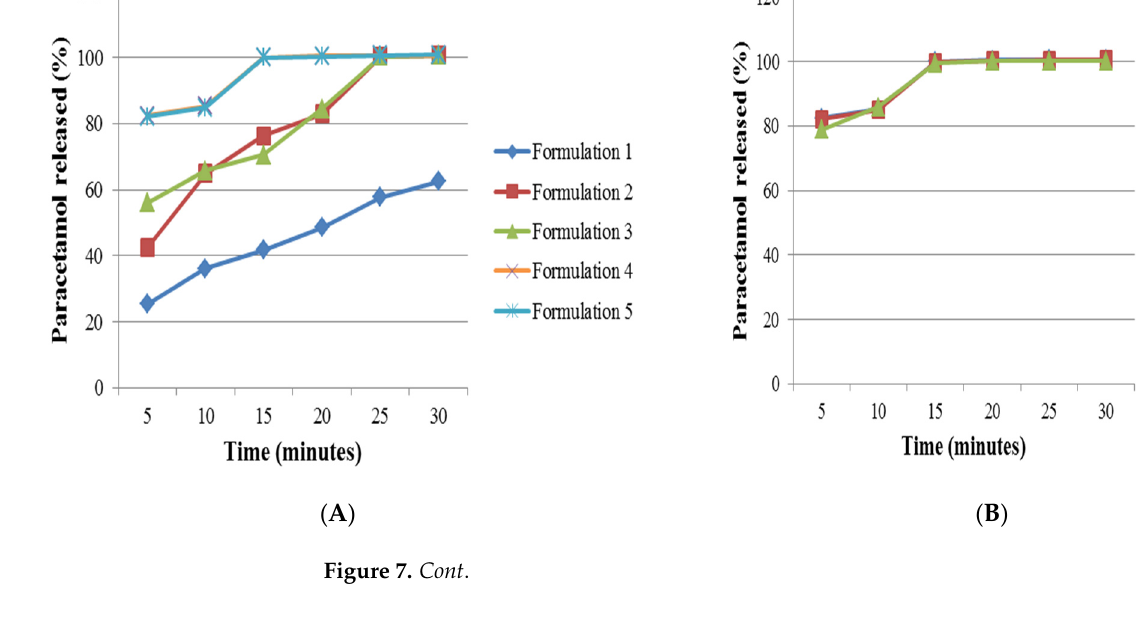
Figure 7. ( A ) Plot of percentage of paracetamol released over time for the dissolution test of each formulation; ( B ) Comparison of paracetamol released (%) between the reference, 3 months and 6 months of storage at conditions 40 ± 2 ° C/75 ± 5% RH for Formulation 4; ( C ) Comparison of para- cetamol released (%) between the reference, 3 months and 6 months of storage at conditions 40 ± 2 ° C/75 ± 5% RH for Formulation 5. Note: n = 6 for all formulations. 4. Conclusions This study indicates that pregelatinised sago starch has the potential to be a new alternative for a directly compressible excipient. Its flow properties were excellent and performed well in the tablet formulations using paracetamol as a model of active ingre- dient, with the resulting tablets exhibiting good stability, satisfactory disintegration time and dissolution properties. Author Contributions: Conceptualization, R.T.W.; methodology, R.T.W.; software, R.T.W.; valida- tion, R.T.W.; formal analysis, R.T.W.; investigation, R.T.W.; resources, R.T.W.; data curation, R.T.W.; writing—original draft preparation, R.T.W.; writing—review and editing, R.T.W., A.H., K.B.L., L.C.M.; visualization, R.T.W.; supervision, A.H.; project administration, R.T.W.; funding acquisition, L.C.M. All authors have read and agreed to the published version of the manuscript. 020